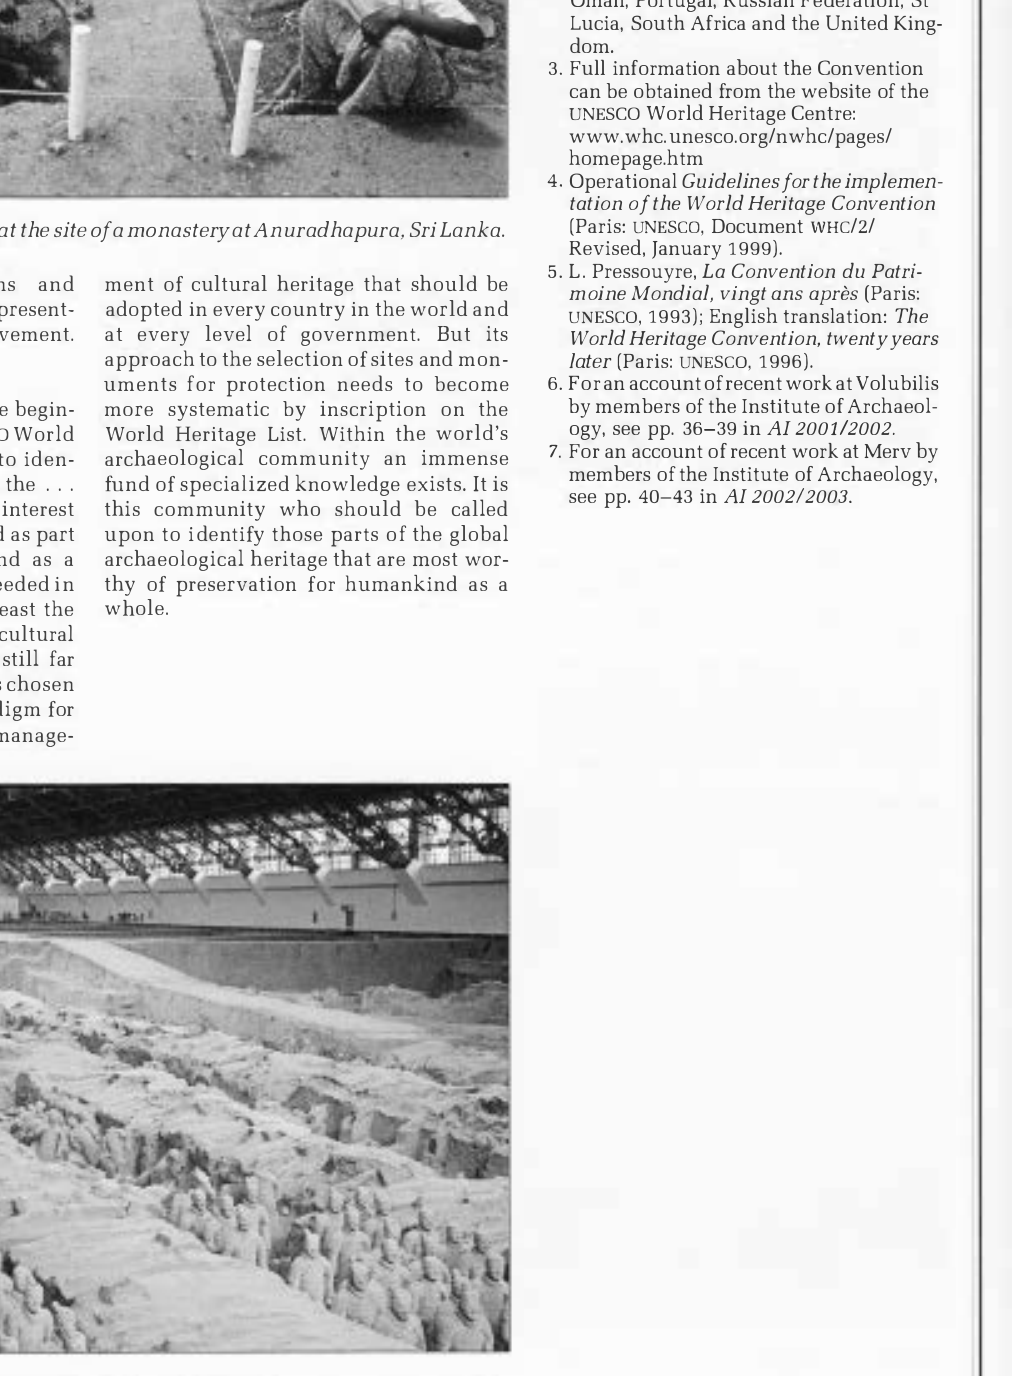
Figure 9 The Museum of the Emperor Qin Shihuang's Terracotta Army, Xi' an,